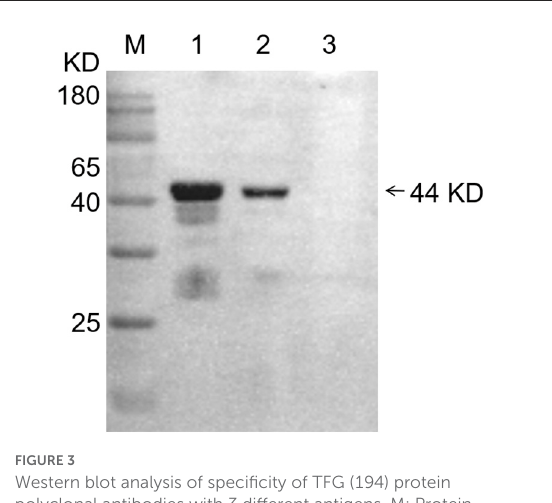
FIGURE3 Western blot analysis of specificity of TFG (194) protein polyclonal antibodies with 3 different antigens. M: Protein molecular weight marker; lane 1: Bovine PBMCs; lane 2: The lysate of T. annulata schizont-transformed cells; lane 3: T. annulata